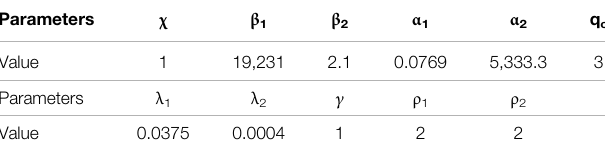
TABLE 2 | Fatigue and recovery time constants τ f and τ r for participants 1, 2, 3, and 4 on both legs.